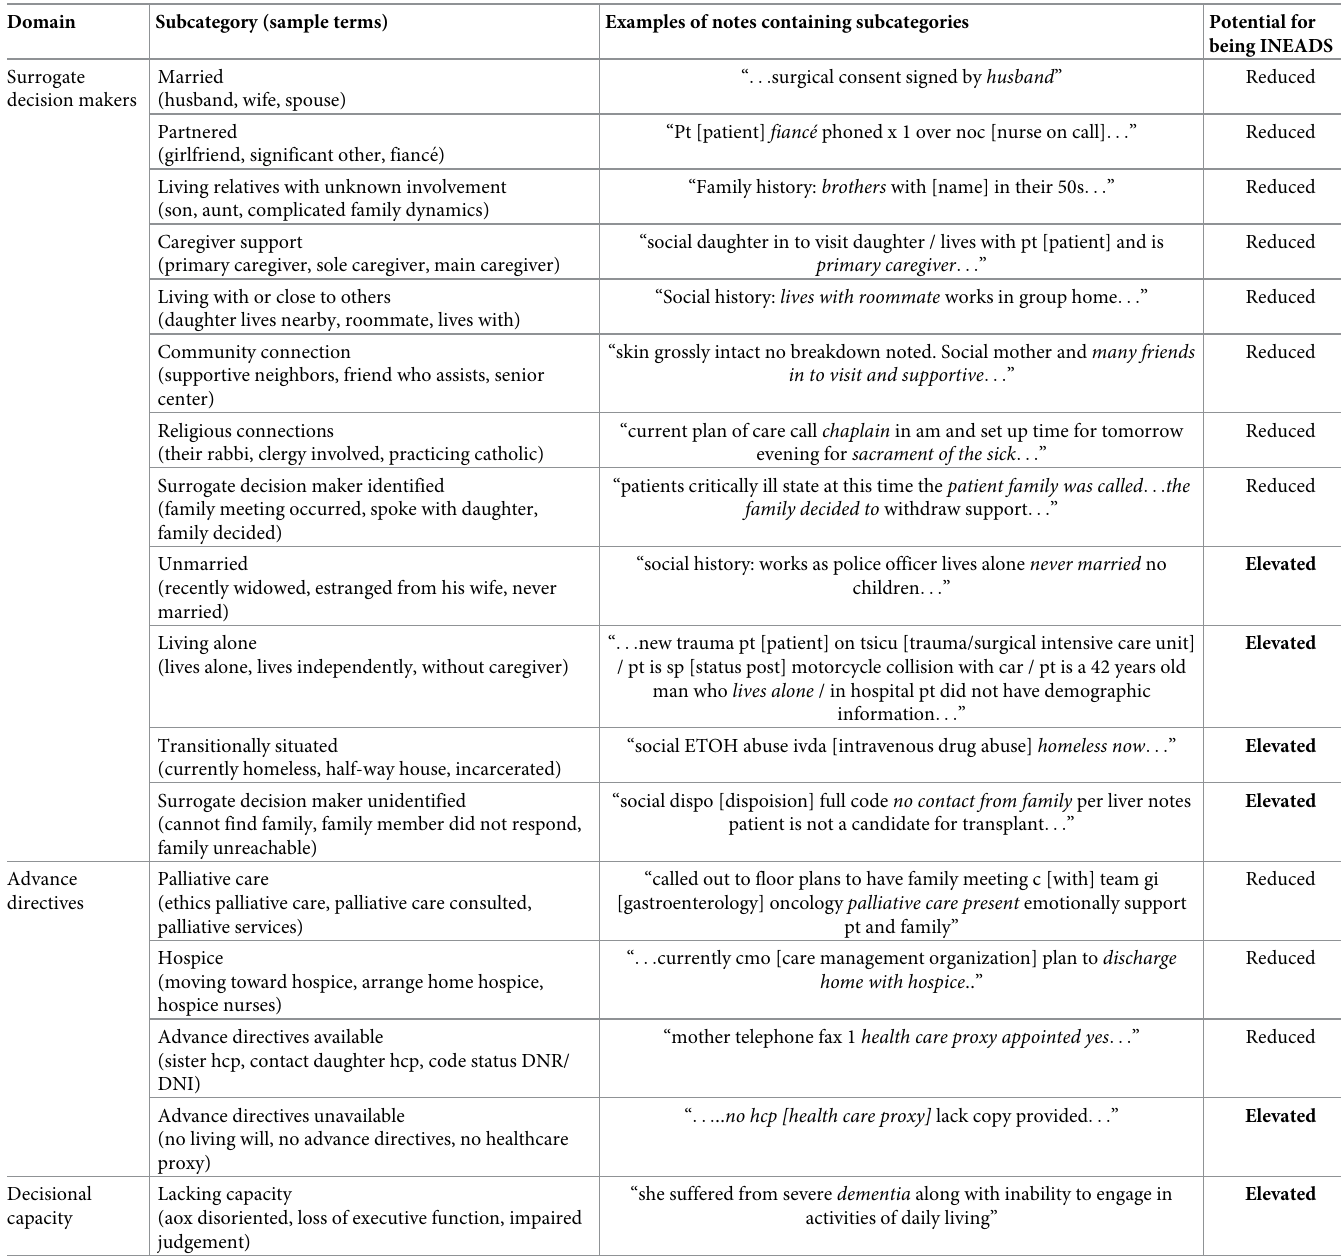
Table 1. Domains and subcategories of terms related to INEADS (Incapacitated with No Evident Advance Directives or Surrogates) status.